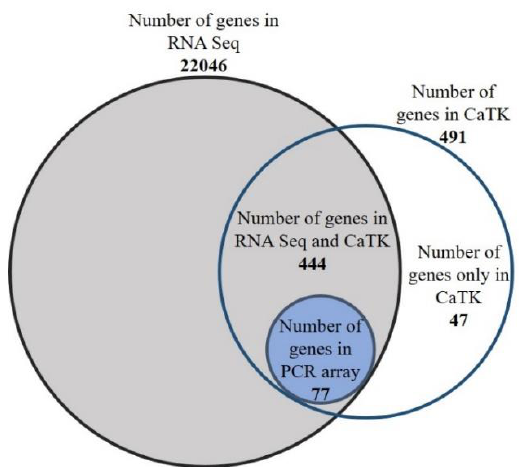
Figure 1. The scheme of the zebrafish Calcium Toolkit (CaTK): The expression of genes that were identified as members of the CaTK was examined by RNA-seq in the brain in adult zebrafish. Next, the mRNA levels of the selected genes were determined in zebrafish brain samples using RT-PCR arrays.